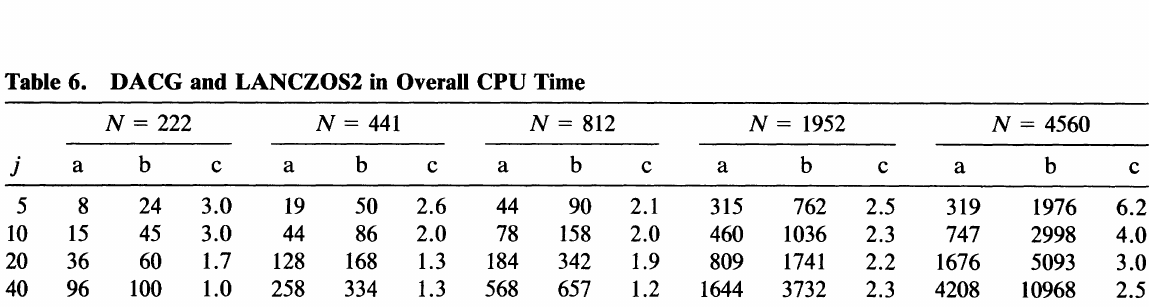
Table 6. DACG and LANCZOS2 in Overall CPU